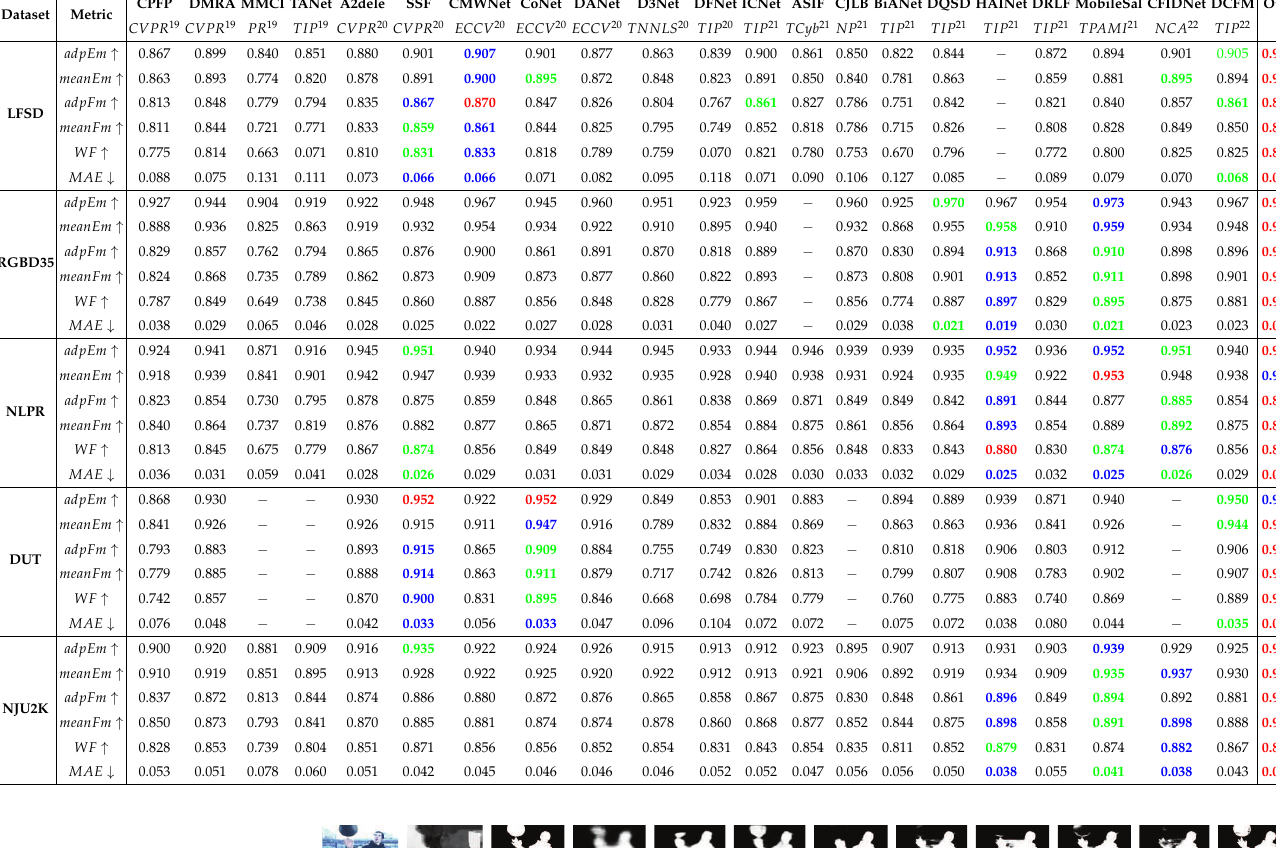
Table 1. Quantitative results of proposed method against 21 state-of-the-art RGB-D SOD methods in terms of adpEm , meanEm , adpFm , meanFm , WF , and MAE . The best top three results are highlighted in red , blue , and green , respectively. ↑ and ↓ stand for larger and smaller is better, respectively.